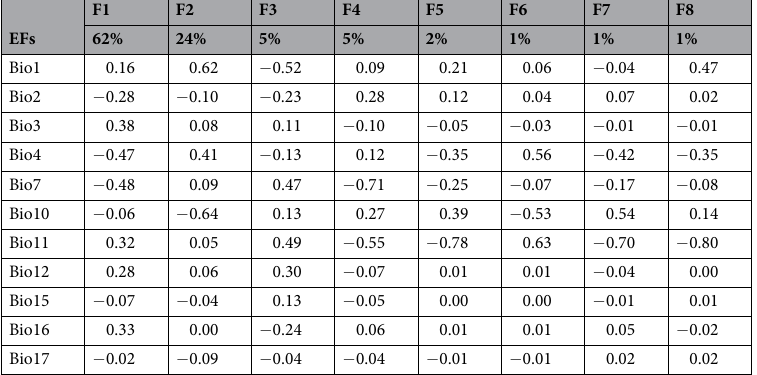
Table 1. Score matrix of current key environmental factors screened by ENFA analysis. EF = environmental factors, F = ecological niche factors identified by ENFA analysis. Marginality = 1.43, speciality = 7.12, tolerance = 0.14.